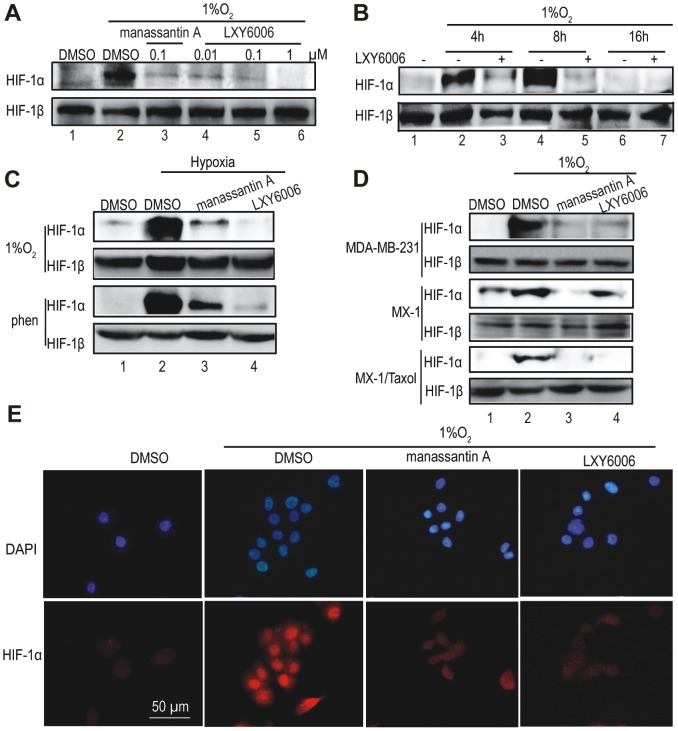
LXY6006 inhibits HIF-1α nuclear accumulation.(A) Nuclear extracts from T47D cells were subjected to Western blotting for HIF-1α and HIF-1β expression. HIF-1β was constitutively expressed and thus used as a loading control. (B) T47D cells pre-treated with or without 0.1 µM of LXY6006 were incubated in hypoxia conditions for different time, and then subjected to Western blotting. (C) T47D cells pretreated with or without 0.1 µM of manassantin A or LXY6006 were exposed to hypoxia (1%O2, 8 hr) or 1,10-phenanthroline (phen) (10 µM, 8 hr), and then lysed for detection of nuclear HIF-1α expression as in (A). (D) MDA-MB-231, MX-1 and MX-1/Taxol cells were treated with or without 0.1 µM of manassantin A or LXY6006 and lysed for HIF-1α expression as above. (E) T47D cells treated with or without 0.1 µM of LXY6006 or manassantin A were exporesed to hypoxia for 8 hr, and then fixed for immunofluorescence straining for HIF-1α expression.